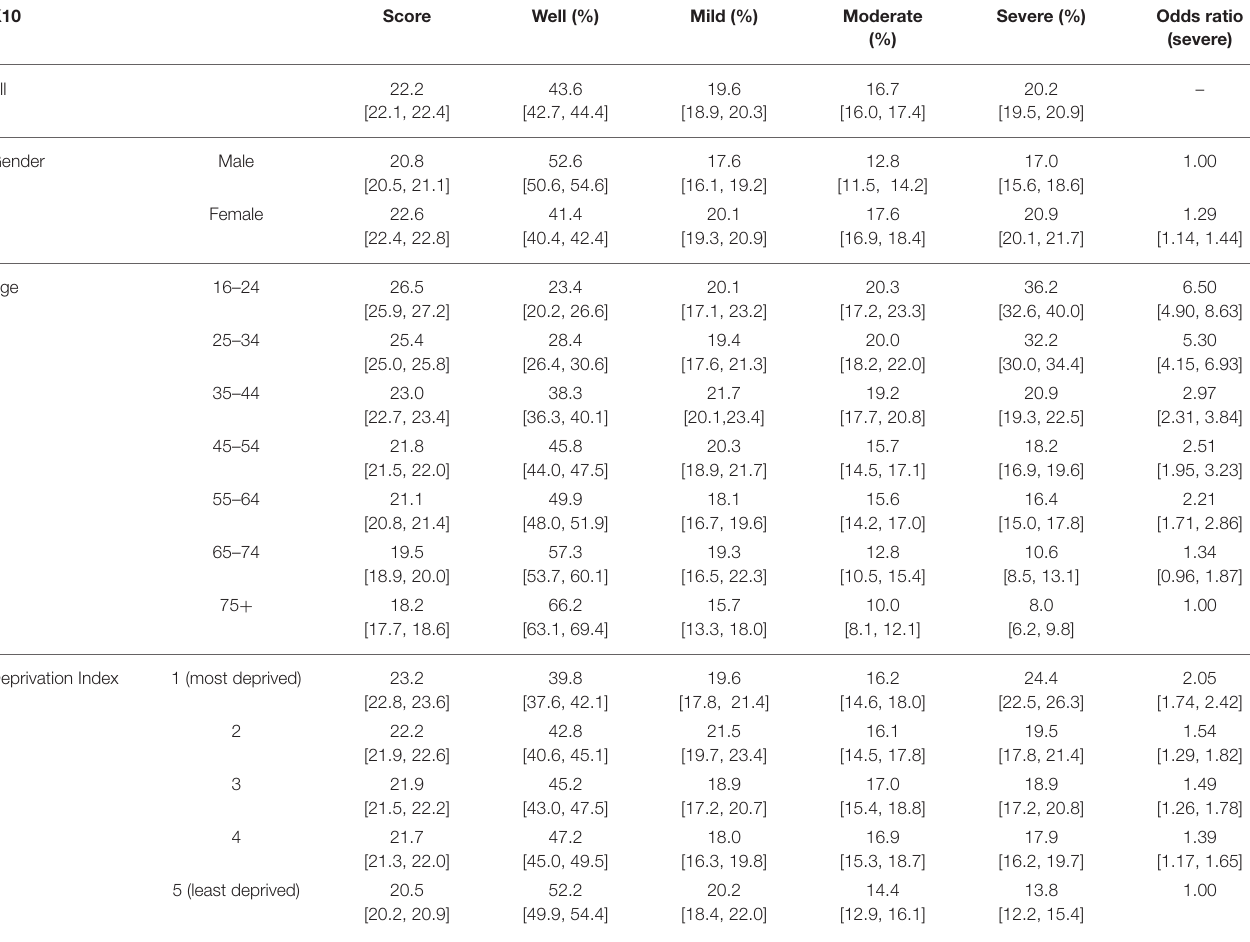
TABLE 3 | Results from the K10 measure of mental distress. Numbers in square brackets represent 95% confidence